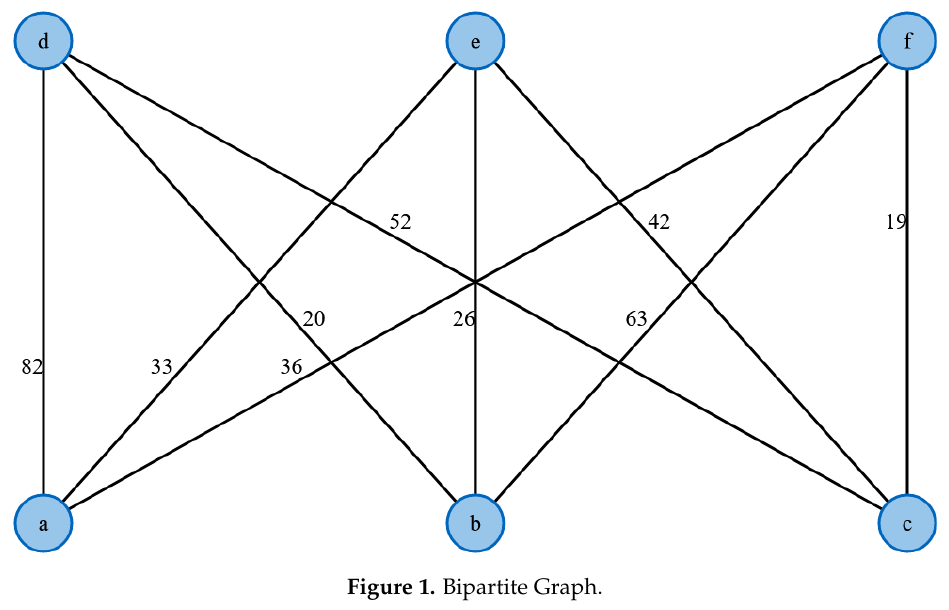
Figure 1. Bipartite Graph.